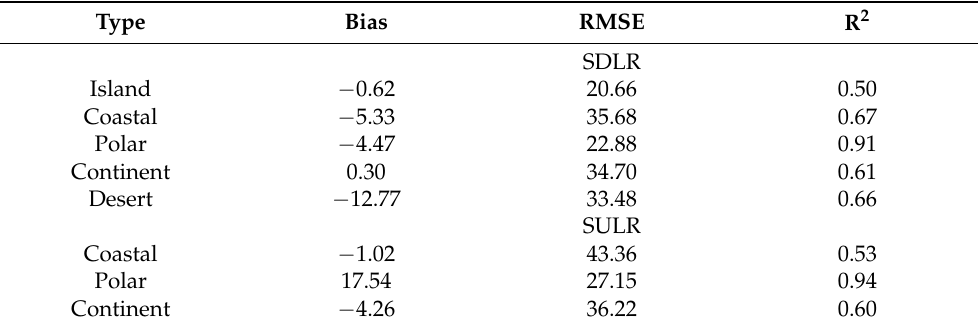
Table 3. Comparison between surface-measured and AMSR2-derived surface upward and downward longwave radiation (SULR/SDLR) components for the coastal, continental, desert, island, and polar sites on land. The units of both bias and root mean square error (RMSE) are W/m 2 . Note that no SULR measurements were available at the island and desert sites.